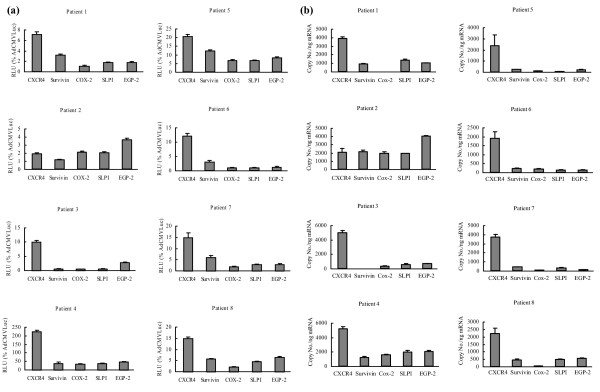
Analysis of candidate promoters for transcriptional targeting of adenovirus-mediated gene expression and correlation to the mRNA copy number of the corresponding genes in primary breast cancer cells. (a) Evaluation of candidate promoters for transcriptional targeting of primary breast cancer cells derived from patients. Primary breast cancer cells were isolated from eight patients and purified and infected with AdCXCR4Luc, AdSurvivinLuc, AdCox2MLuc, AdSLPILuc, AdEGP-2Luc or AdCMVLuc, at a multiplicity of infection of 100. Gene expression was measured 24 h after infection and is presented for the candidate promoters as percentage of cytomegalovirus promoter activity in relative light units (RLU). Each bar presents the mean of three experiments ± standard deviation. (b) Gene expression of candidate tumor-specific genes in breast cancer patient samples. Messenger RNA was extracted from human primary breast cancer samples from eight patients and reverse-transcribed into cDNA. Real-time PCR was performed to evaluate the expression of the genes encoding cyclooxygenase (Cox)-2, epithelial glycoprotein (EGP)-2, secretory leukoprotease inhibitor (SLPI), survivin and the α-chemokine SDF-1 receptor (CXCR4). The mRNA copy numbers are normalized by the glyceraldehyde-3-phosphate dehydrogenase copy number. Each bar presents the mean of three experiments ± standard deviation.